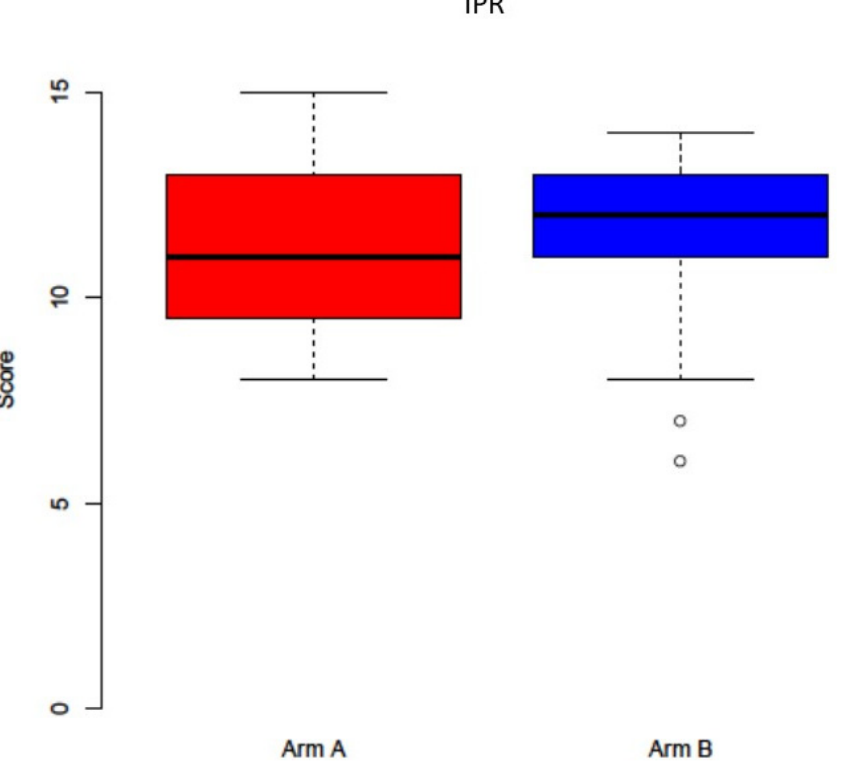
Figure 3. The IPR wound healing score showed no statistical differences between study arm A ( − PRF, red boxplot) and B (+PRF, blue boxplot, p = 0.302).